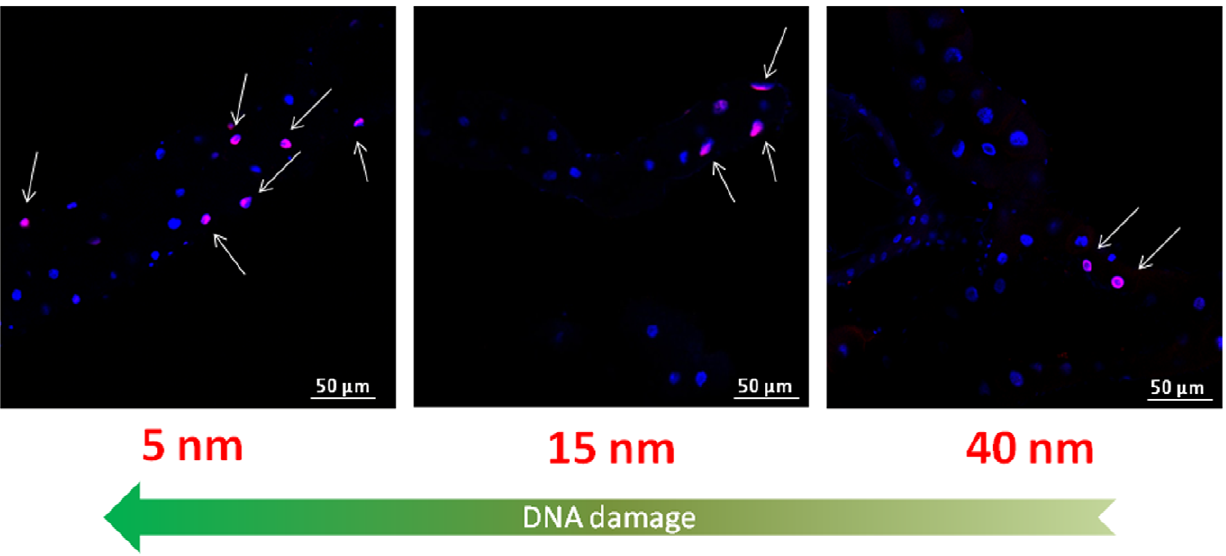
Figure 4. Representative confocal microscopy images of Drosophila midgut in flies obtained from TES treatment. Nuclei are stained with Hoechst 33342 (blue) while cells containing DNA strand nicks are detected by TUNEL assay and fluoresce red (highlighted by the white arrows).